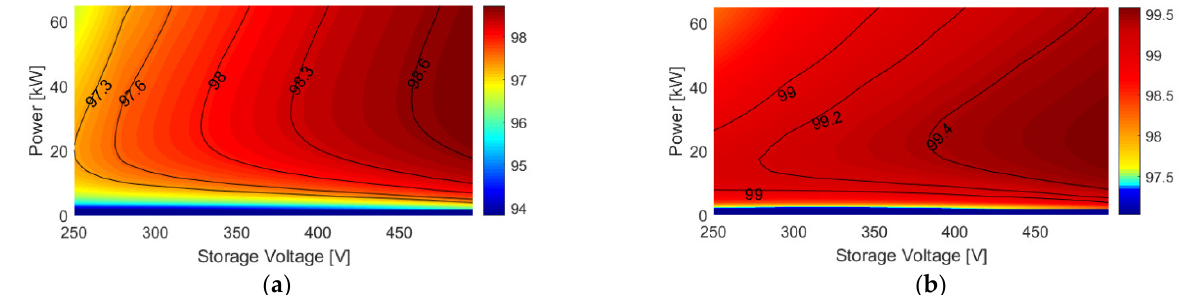
Figure 3. DC-DC converter losses ( a ) Si DC-DC converter losses. ( b ) SiC DC-DC converter losses in per unit.